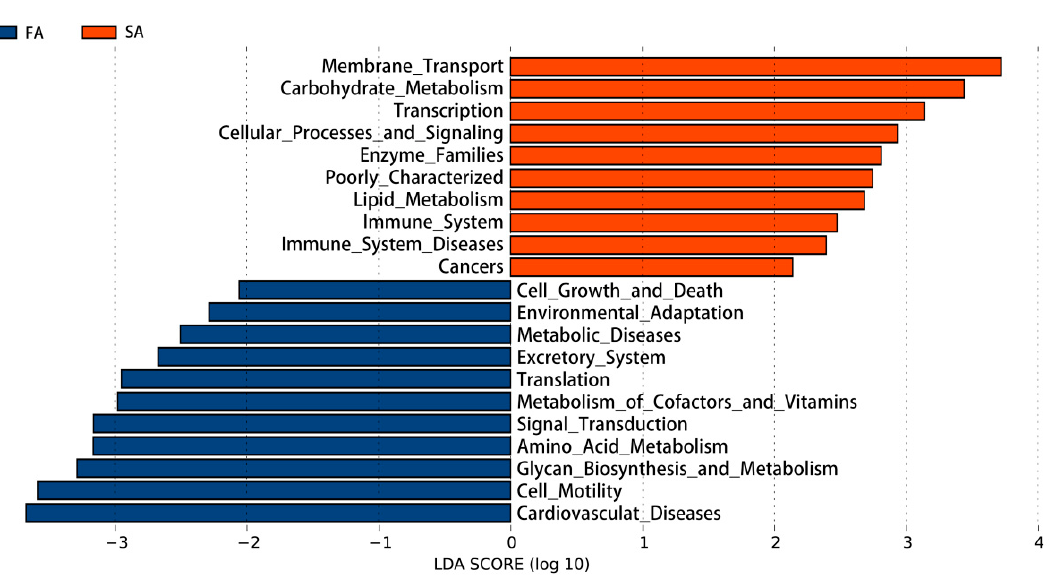
Figure 5. Differences in gut microbial function prediction between the SA and the SR treatments. SA: slow-growing chickens fed ad libitum, SR: slow-growing dual-purpose chickens with feed restriction.